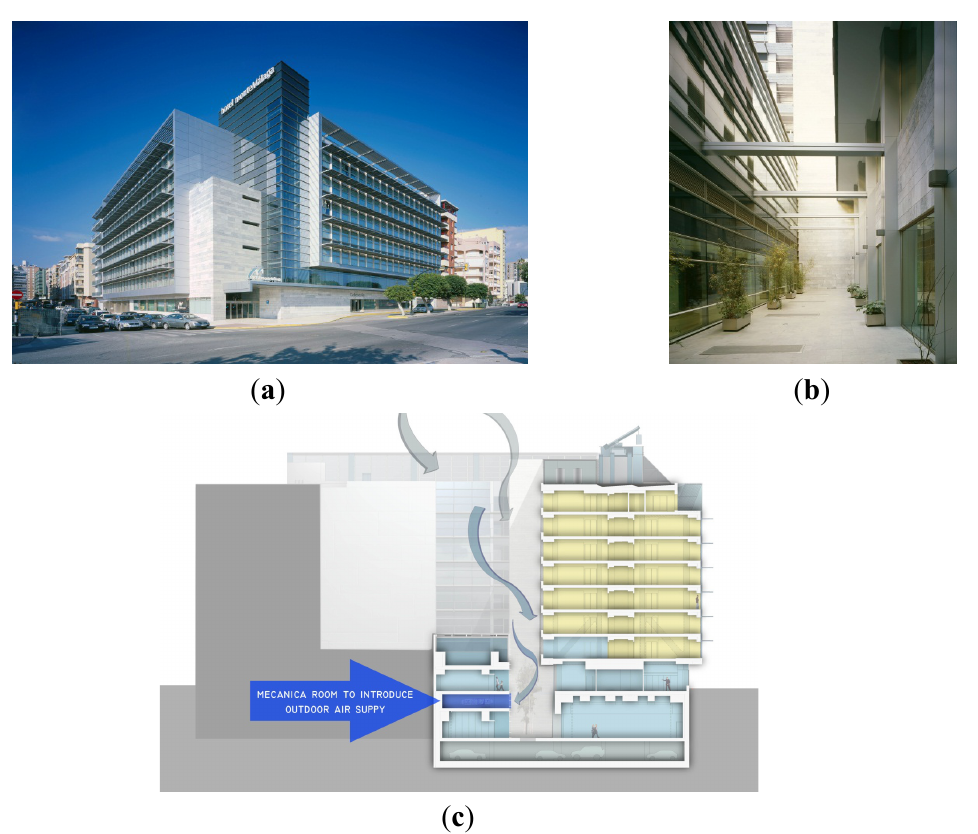
Figure 14. ( a ) Image of the Monte Málaga Hotel; ( b ) the deep courtyard, and ( c ) section with air circulation